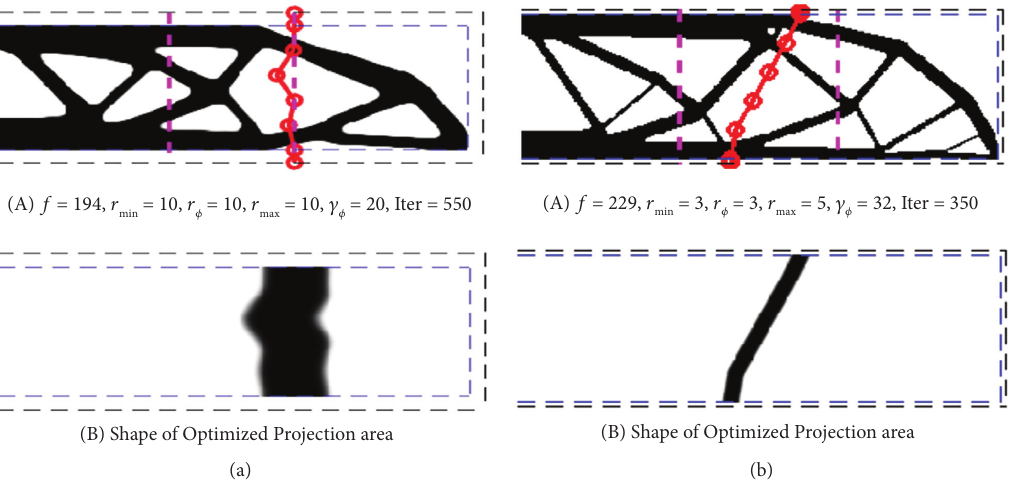
Figure 6: Optimized topologies and compliance for various constraints values. (a) x � 20, and iter � 550. (B) Shape of the optimized projection area. (b) x r max � 10, c Φ c � 32, and iter � 350. (B) Shape of the optimized projection Φ